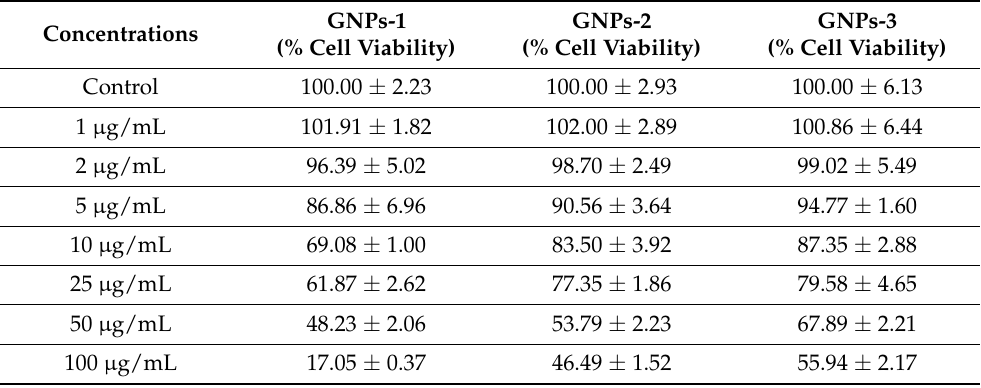
Table 2. Comparative anticancer activity of gold NPs against liver cells by NRU assay. Concentrations